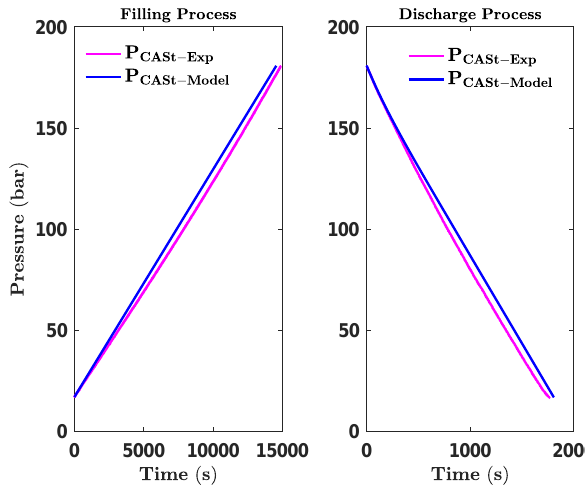
Figure 5. Comparison of model and experimental results for the charge and discharge tests.